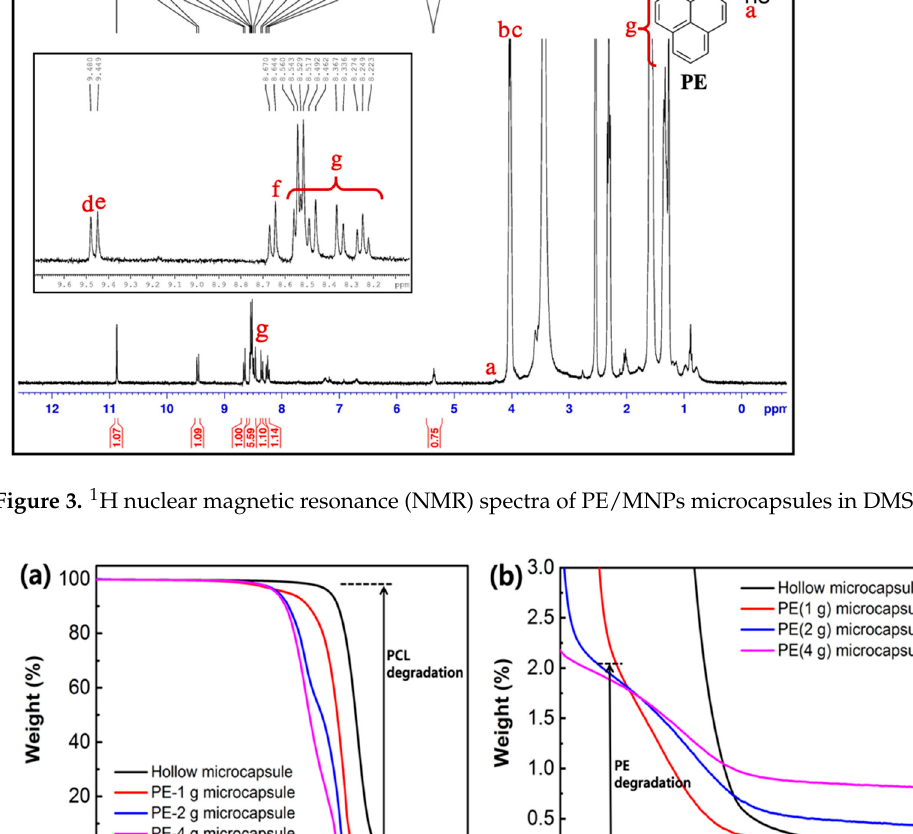
Figure 3. 1 H nuclear magnetic resonance (NMR) spectra of PE/MNPs microcapsules in DMSO.